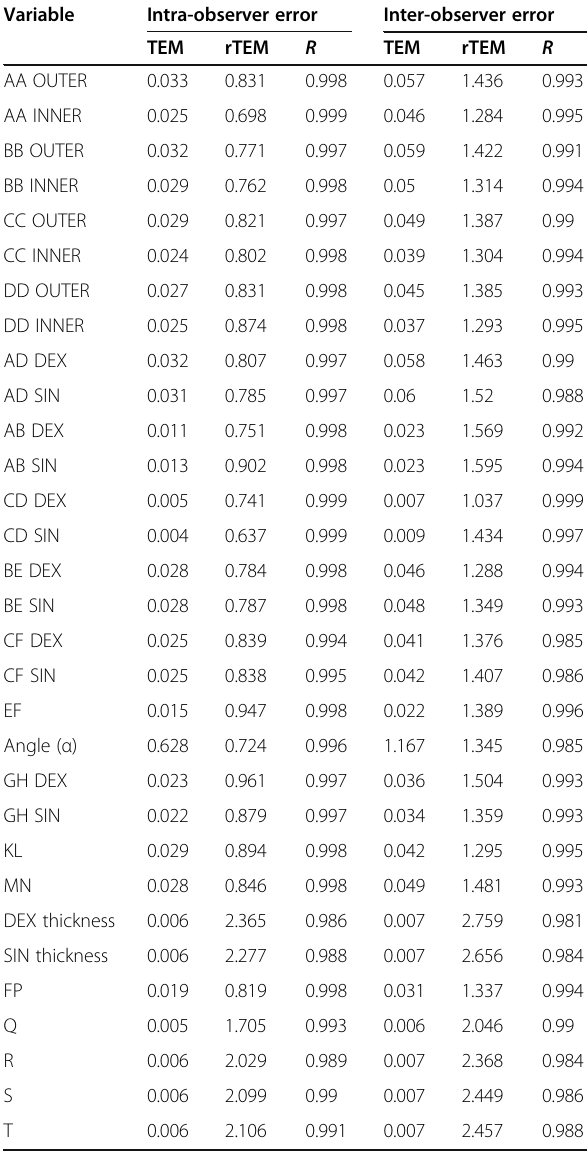
Table 3 The technical error of measurement (TEM), relative technical error of measurement (rTEM) and the coefficient of reliability ( R ) ( n = 25)